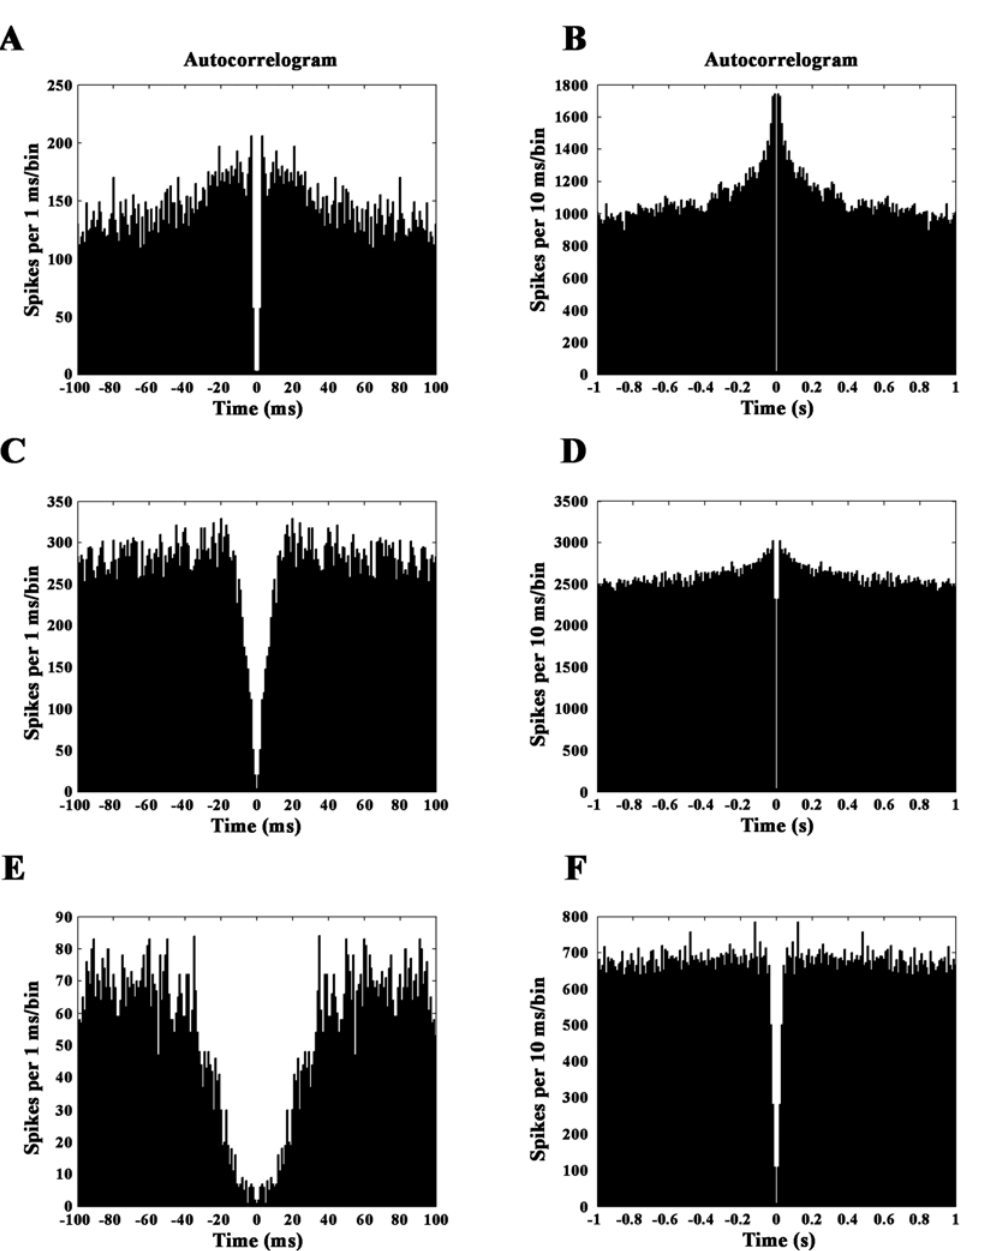
Fig 2. Autocorrelograms of the CN neurons. Neurons were classified on the basis of the shape of their autocorrelograms (at 100 ms and 1000 ms time resolutions), propISI > 2sec and the background discharge rate in three big groups (PAN, HFN, TAN). Neurons belonging to each group have characteristic autocorrelogram. PANs are usually characterized by peaky autocorrelogram (A,B). HFNs have autocorrelograms with a blunt peak (C,D) and TANs are characterized by a deep gap in the autocorrelogram